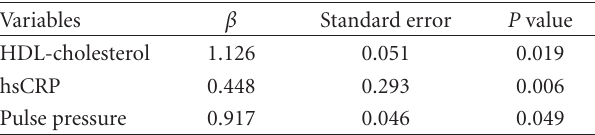
Figure 1: Correlation of carotid intima-media thickness (IMT) with C-reactive protein (a) and with HDL-cholesterol (b). Table 2: Logistic regression model for increased carotid intima- media thickness (IMT > 0.9mm) as dependent